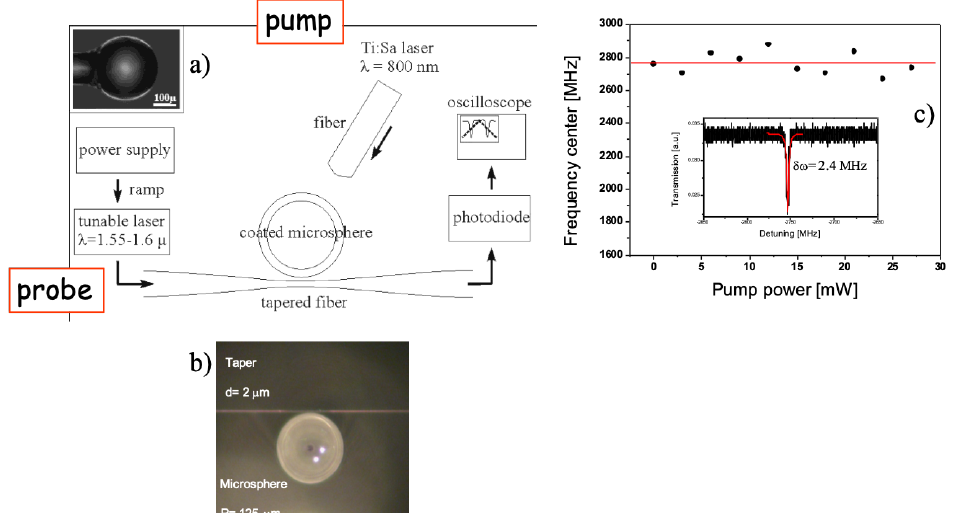
Figure 11. ( a ) Experimental pump-and-probe set-up. Left hand side inset: optical image of the WGMR. ( b ) Picture of the microsphere and the coupling taper; ( c ) Frequency center of the WGMR resonance versus pump power. The red line is a guide to the eye. Inset: Zoom of a typical resonance for a bare microsphere, the red line is a Lorentzian fit with a FWHM of about 2.4 MHz. Reproduced with modifications from